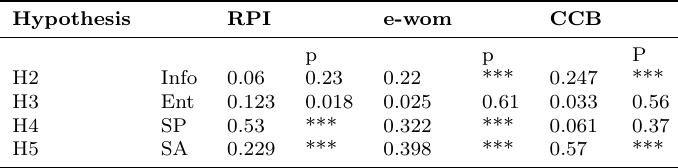
Table 5: Hypothesis testing for Control